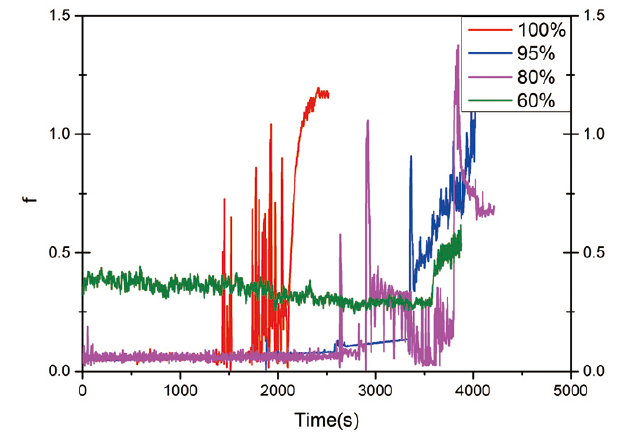
Figure 8. Variation of frictional resistance coefficient in pipelines with different water cut